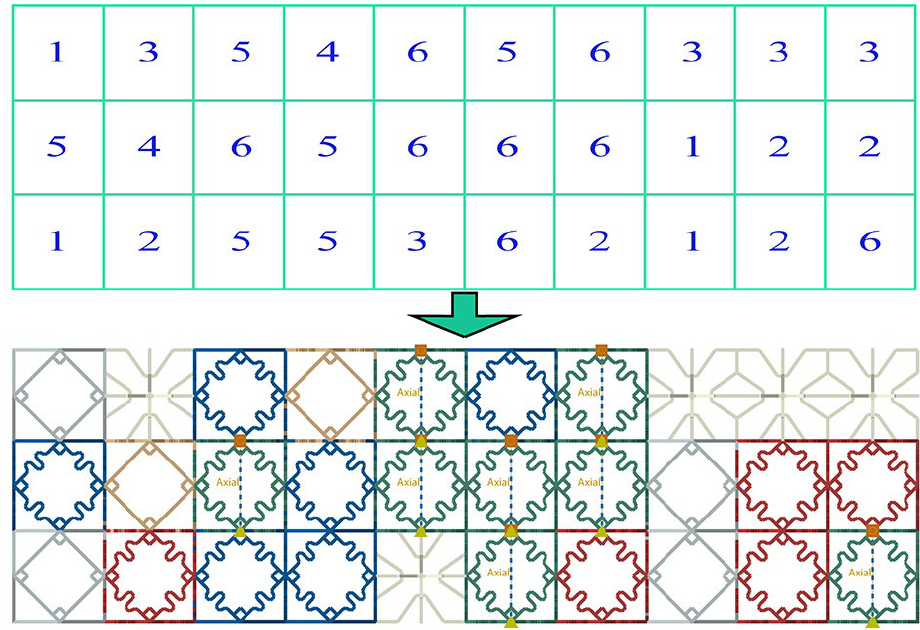
Figure 20. Diagram of the corresponding relationship between a specific sequence and its cell combination configuration.